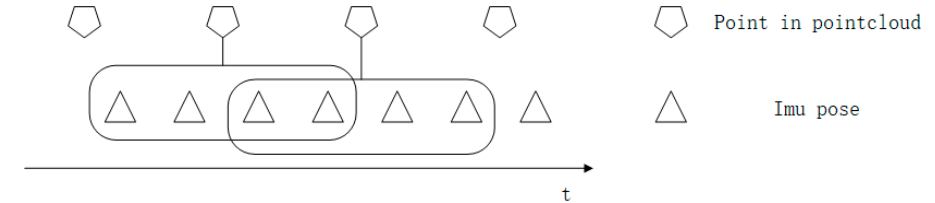
Figure 5. The pose of every point.